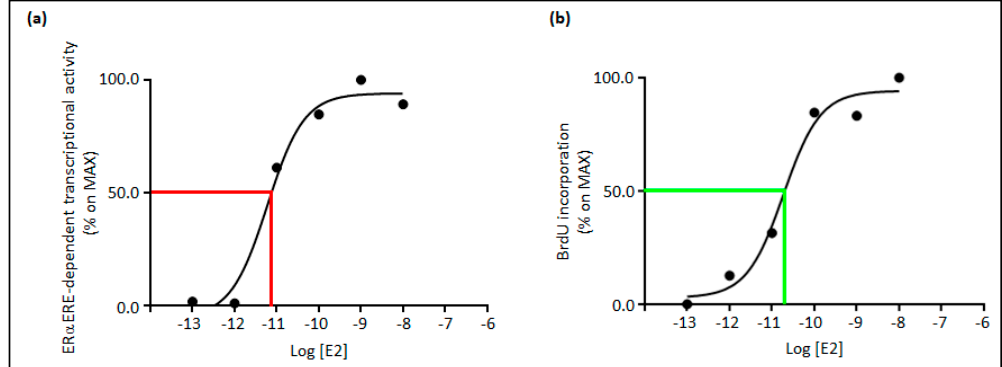
Figure 2. The E2 concentration-dependent effect on gene transcription and DNA synthesis. ( a ) ER α ERE-dependent transcriptional activity has been measured at 24 h in MCF-7 cells as described in [43] as a function of the indicated doses of 17 β -estradiol (E2); ( b ) Bromodeoxyuridine incorporation (BrdU) in DNA has been measured at 24 h in MCF-7 cells as described in [43] as a function of the indicated doses of 17 β -estradiol (E2). Red and green lines indicate half-maximal effect. For detail, see the text. 17 β -estradiol (E2); estrogen receptor α (ER α ); estrogen responsive element (ERE).